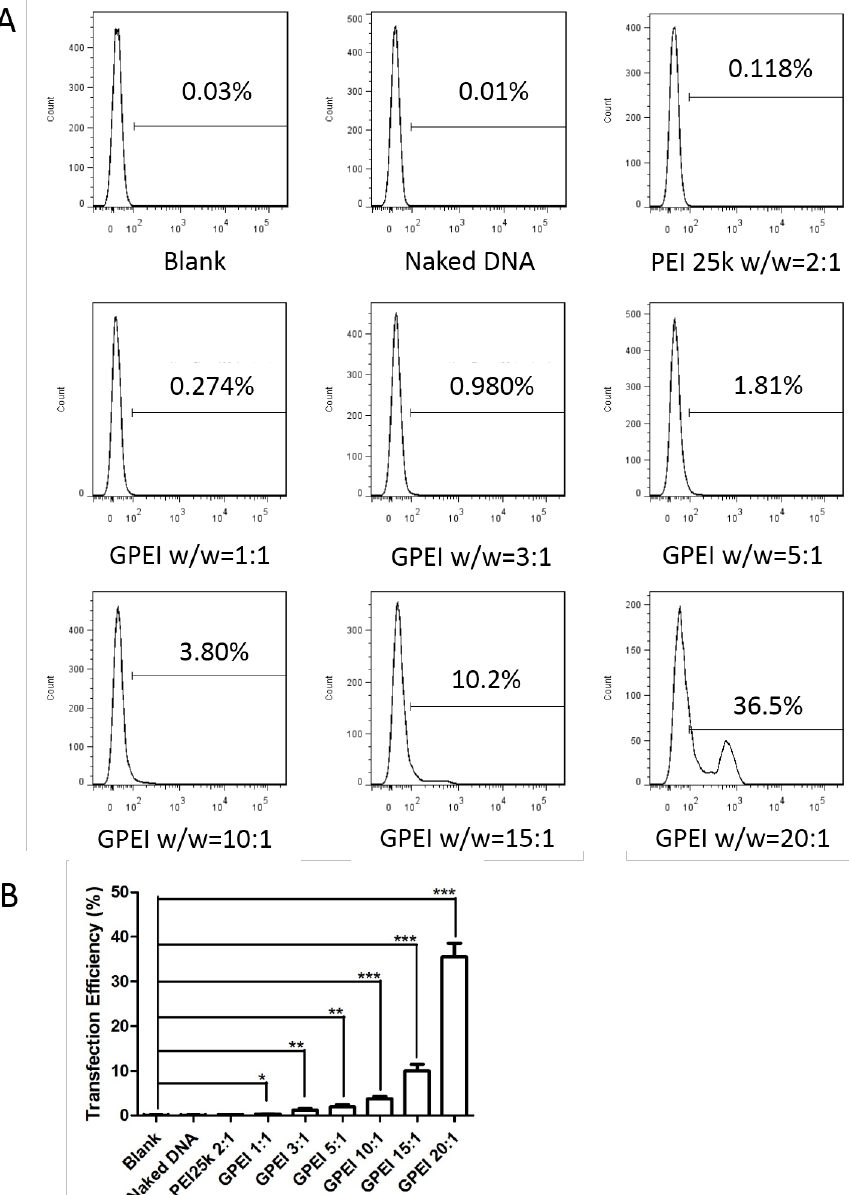
Figure 6. In vitro cell transfection efficiency of the GPEI polyplexes for HUVECs. ( A ) The transfection efficiency analyzed by software FlowJo. ( B ) In vitro transfection efficiency (data are presented as mean values ± S.D. ( n = 3, *: p < 0.05 **: p < 0.01 ***: p < 0.001).